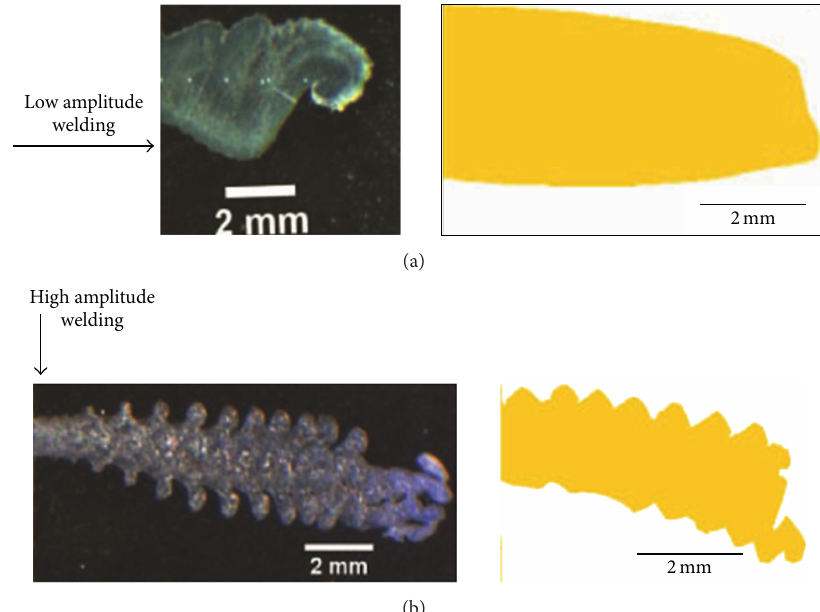
Figure 6: Examples of flash formation during LFW; top: smaller amplitude and high applied load and associated modelling; bottom: large amplitude and lower applied load and associated modelling